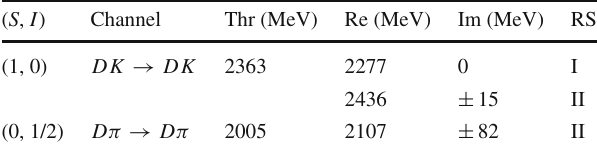
Table 6 Poles in the single-channel amplitudes based on UChPT-6(b) in Table 4 of Ref. [32]. Physical masses are used to obtain the poles. The Riemann sheets on which the poles are located are indicated in the last column